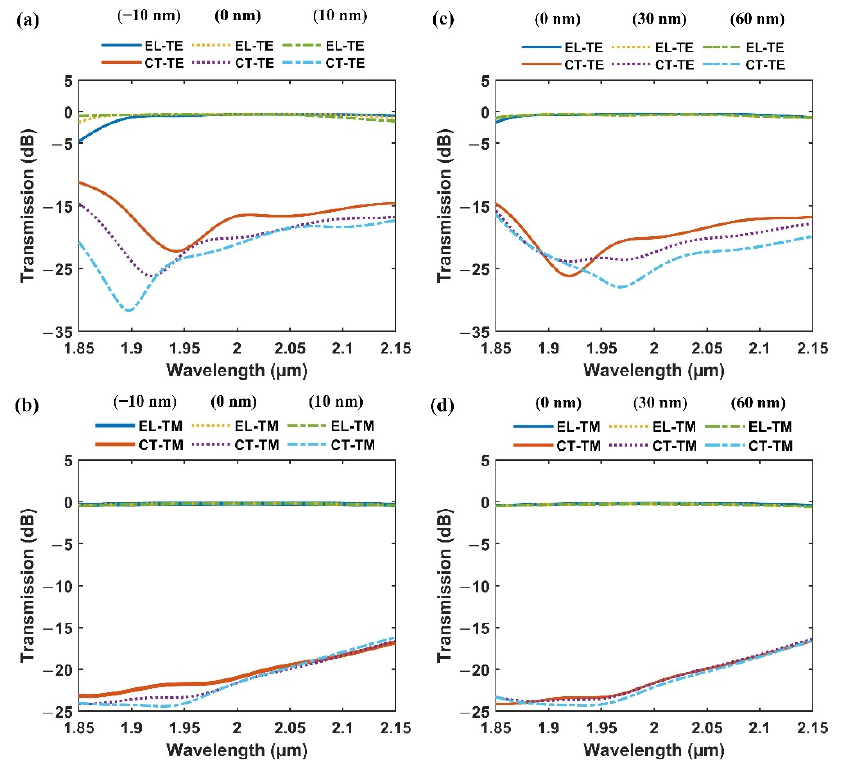
Figure 6. The transmission spectra with ± 10 nm pixel size variations for ( a ) TE and ( b ) TM modes; the transmission spectra of ( c ) TE and ( d ) TM modes for different air gap thicknesses.